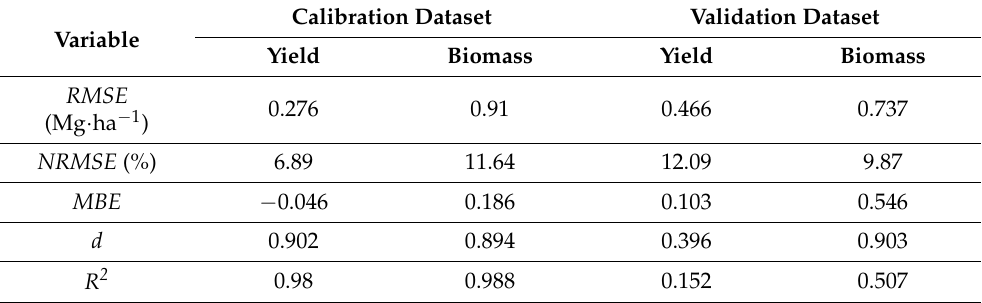
Table 5. Statistical indices of yield and total biomass for calibration and validation